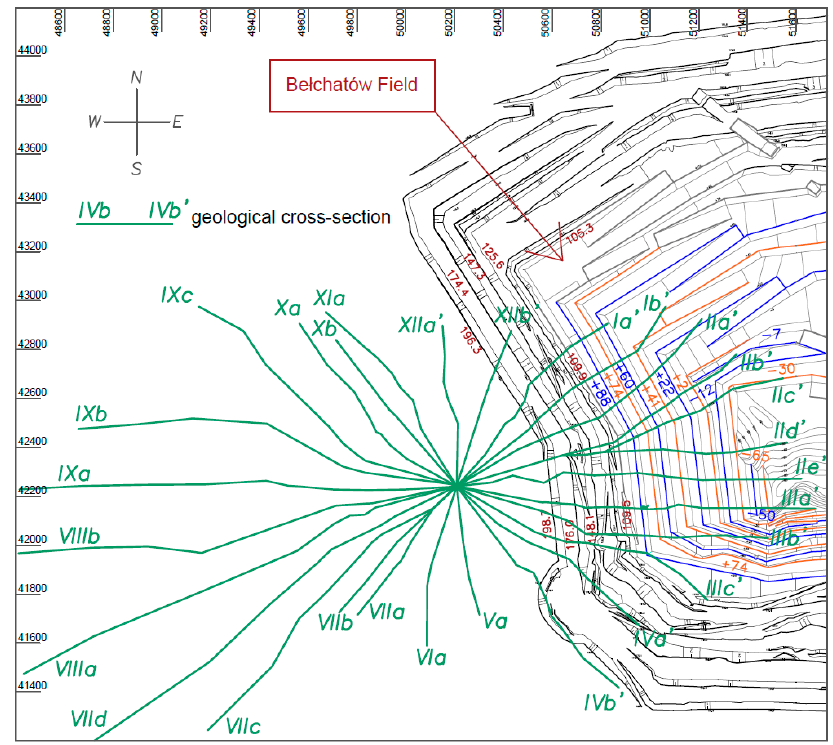
Figure 3. Location of the geological cross-sections crossing at the DSD center. The western slope of Be ł chatów field (WSBF) (on the right side) on the background of the completed benches (marked black with red captions) and the designed benches (marked blue and orange).